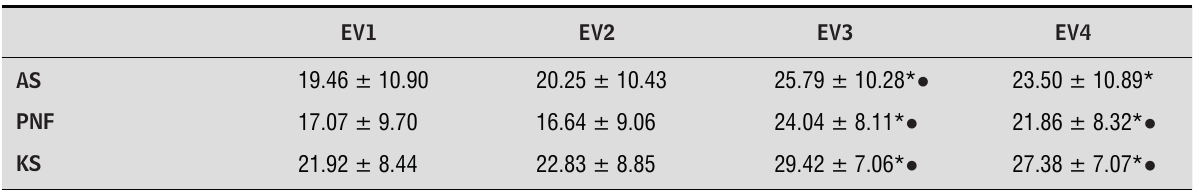
Table 2 - Results of the assessment with the Wells’ Bench, in centimeters, values presented as mean and standard devia- tion for different groups in different time points